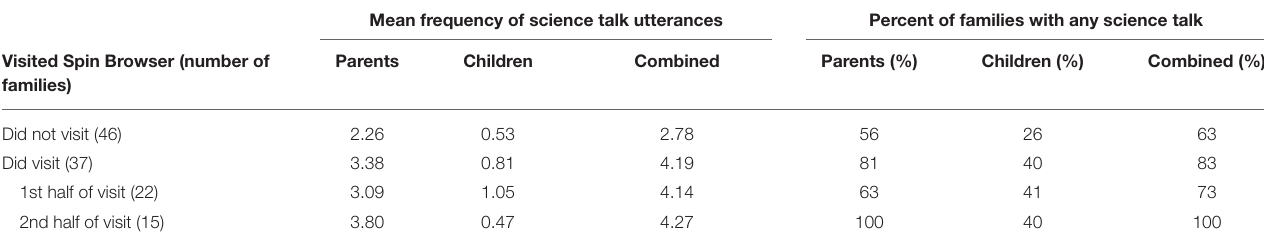
TABLE 4 | Mean number of explanatory science talk utterances by parents and children and percent of families with any science talk as a function of whether they visited the Spin Browser exhibit. Mean frequency of science talk utterances